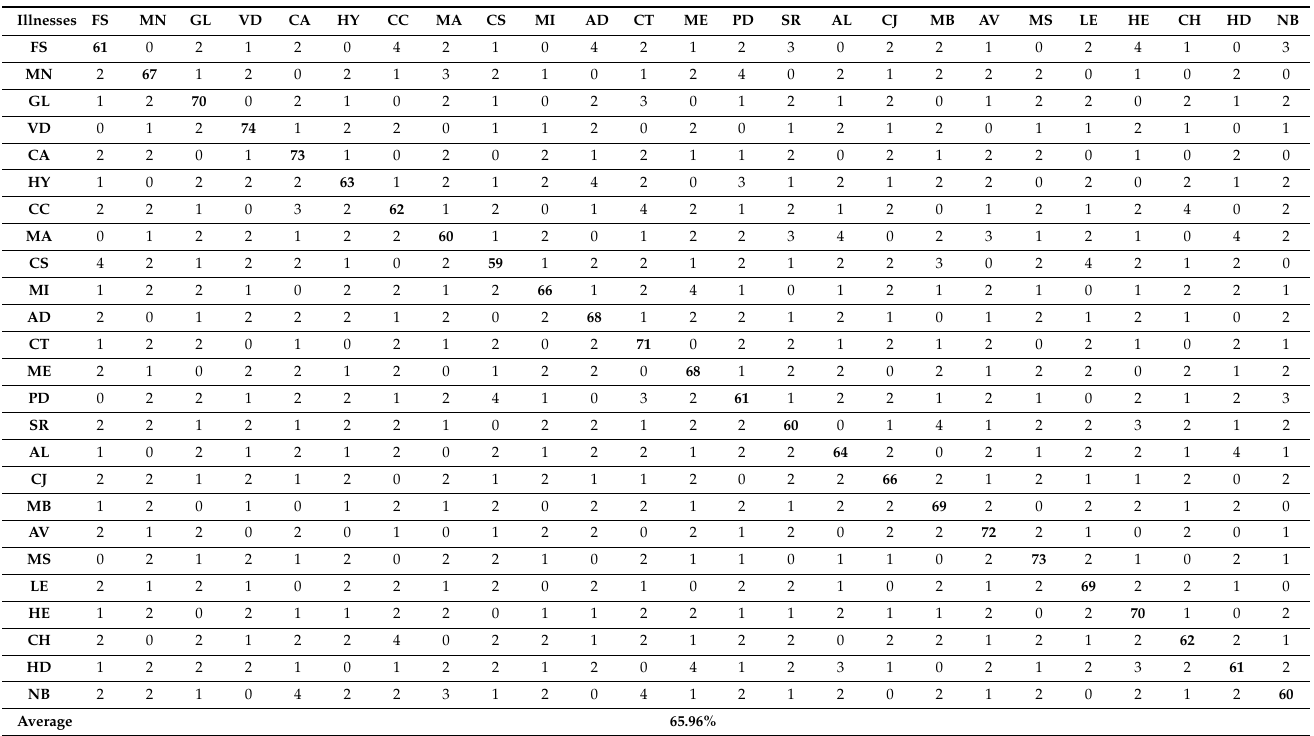
Table 6. Performance of Partial Least Squares method (instead of using the developed approach) using MRI dataset (Unit %).